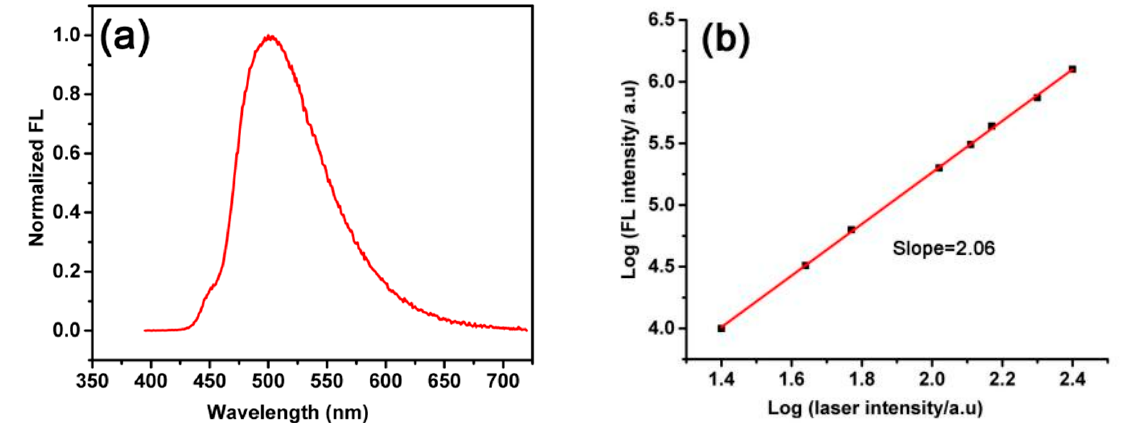
Figure 5. ( a ) Normalized two-photon-excited emission spectra in toluene; ( b ) the logarithmic plots of power-squared dependence of two-photon-excited fluorescence intensity on the laser intensity.